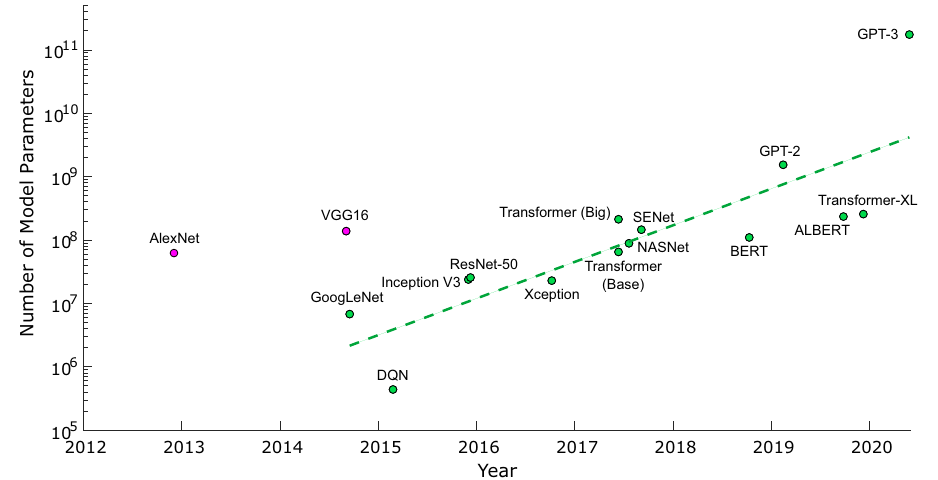
Figure 1. Number of parameters, i.e., weights, in recent landmark neural networks 1,2,31–43 (references dated by first release, e.g., on arXiv). The number of multiplications (not always reported) is not equivalent to the number of parameters, but larger models tend to require more compute power, notably in fully-connected layers. The two outlying nodes (pink) are AlexNet and VGG16, now considered over-parameterized. Subsequently, efforts have been made to reduce DNN sizes, but there remains an exponential growth in model sizes to solve increasingly complex problems with higher